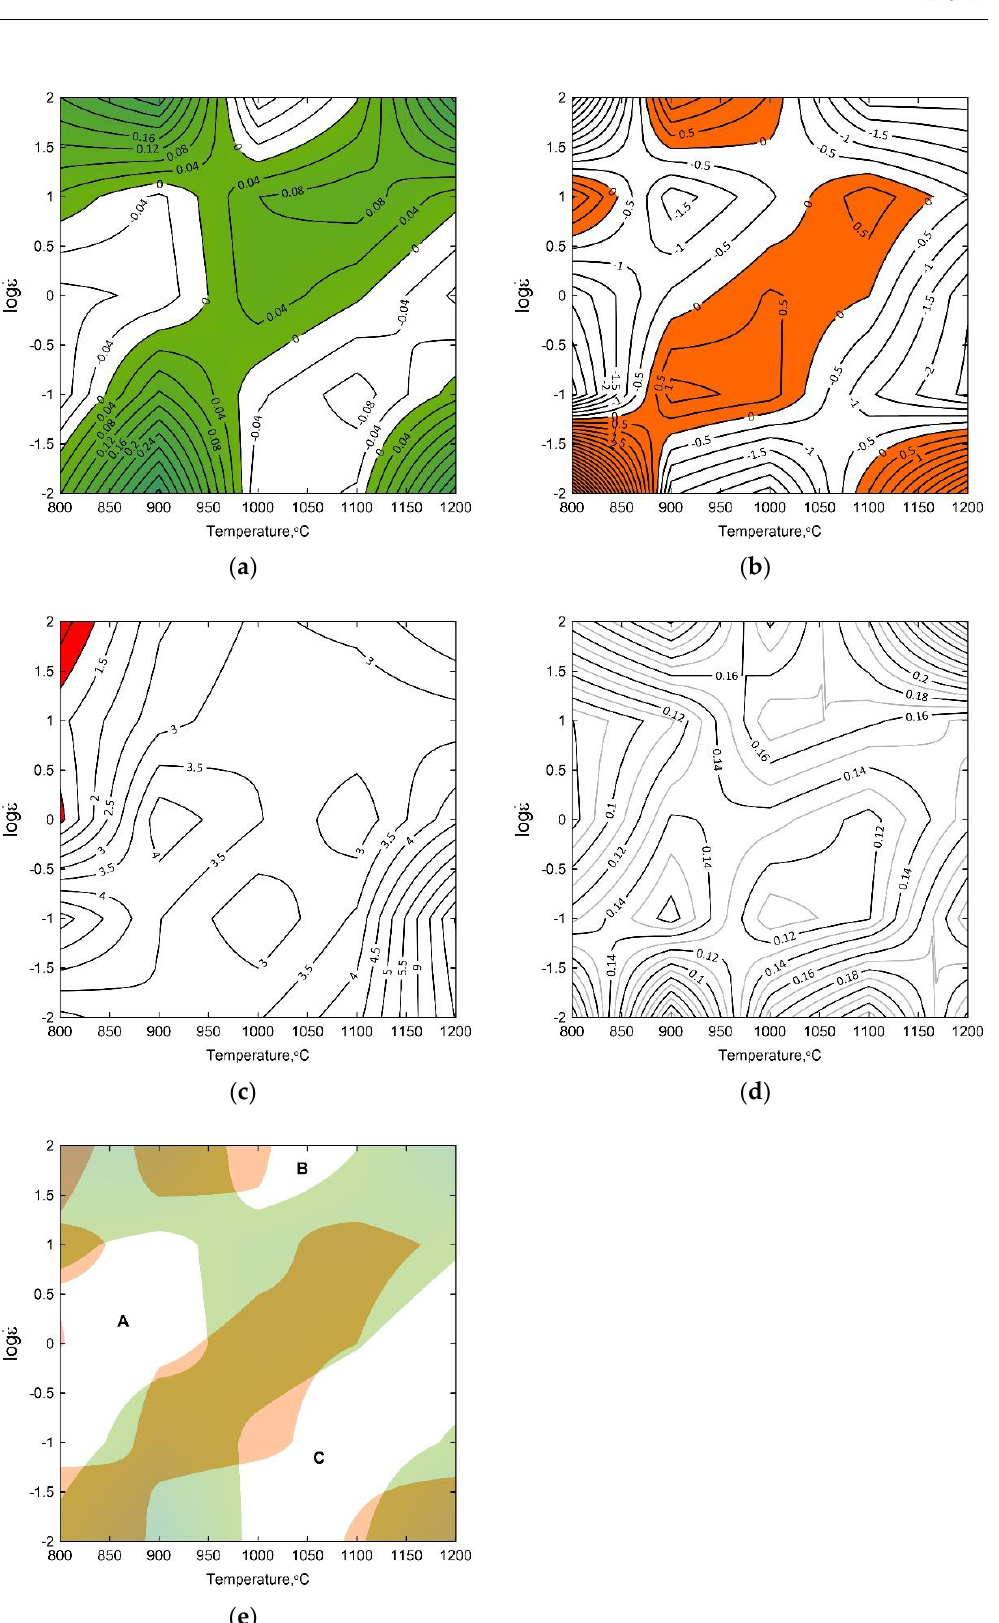
Figure 4. Contour map for the η criterion ( a ), contour map for the s criterion ( b ), contour map for the temperature-sensitivity parameter of flow stress s ( c ), the maps of changes in the strain-rate-sensitivity parameter m ( d ) and the processing map based upon Gegel’s stability criterion ( e ) for the 4130 steel for the true strain of 1, A, B, C-domains of flow